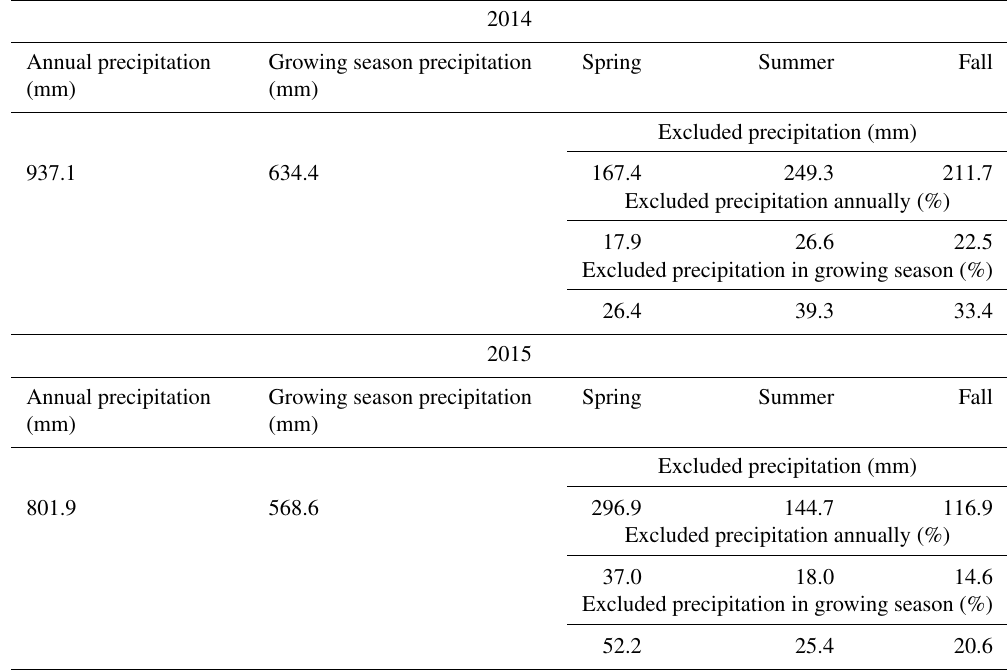
Table 1. Amount of precipitation that has fallen in the 2 years of the experiment, and the amount of excluded precipitation during the sheltered drought periods in the years 2014 and 2015. Growing season precipitation refers to the time period between the first setup of the shelters in spring and the last harvest of each